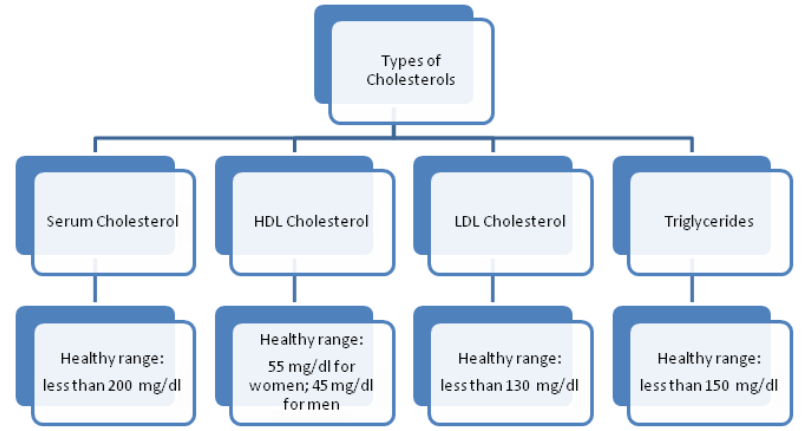
Figure 2. Types of Cholesterol and their healthy ranges.